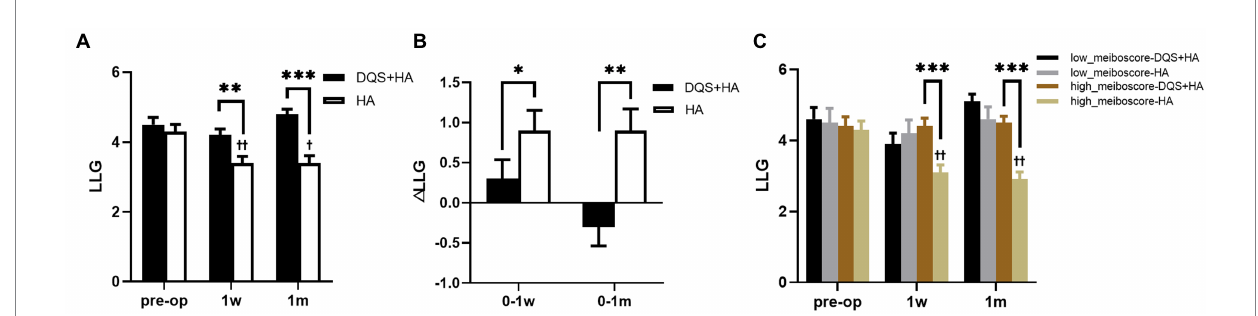
FIGURE 3 Changes in LLG in patients after FS-LASIK (A,B) and in different meiboscore subgroups (C) . Mean value±standard error. The sample sizes of low meiboscore-DQS + HA group, low meiboscore-HA group, high meiboscore-DQS + HA group, and high meiboscore-HA group were 16, 12, 24, and 28 eyes, respectively. * p < 0.05, ** p < 0.01, and *** p < 0.001 between the combination group and the HA group by Mann–Whitney U test. † p < 0.05 and †† p < 0.01 between preoperative visit and postoperative visits in the HA group by Friedman test. LLG, lipid layer grade; DQS, diquafosol tetrasodium; HA, sodium